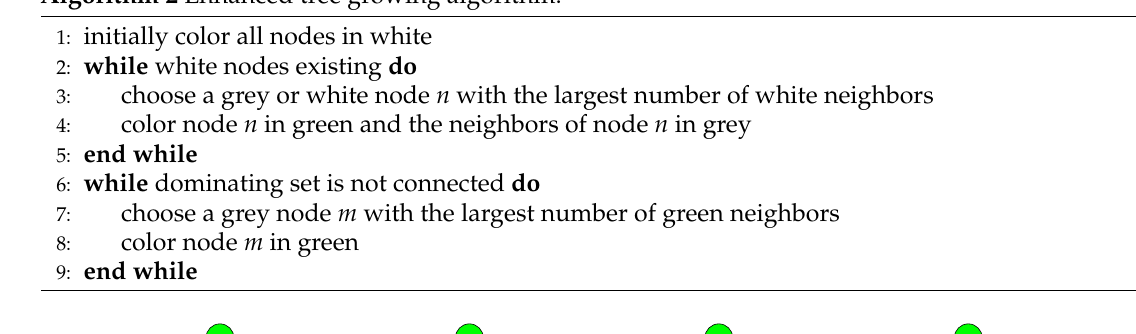
Algorithm 2 Enhanced tree growing algorithm.